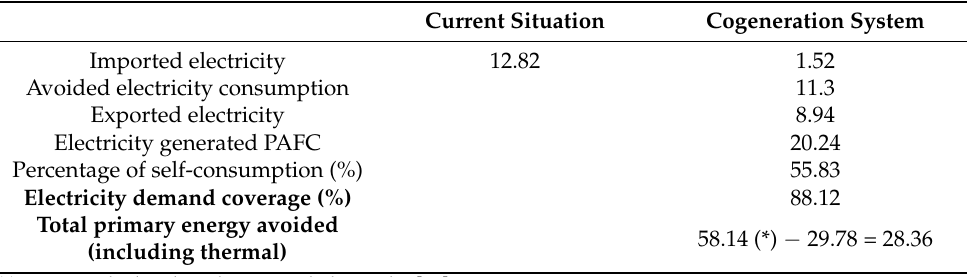
Table 12. Annual electricity energy balance for the chosen alternative (GWh).